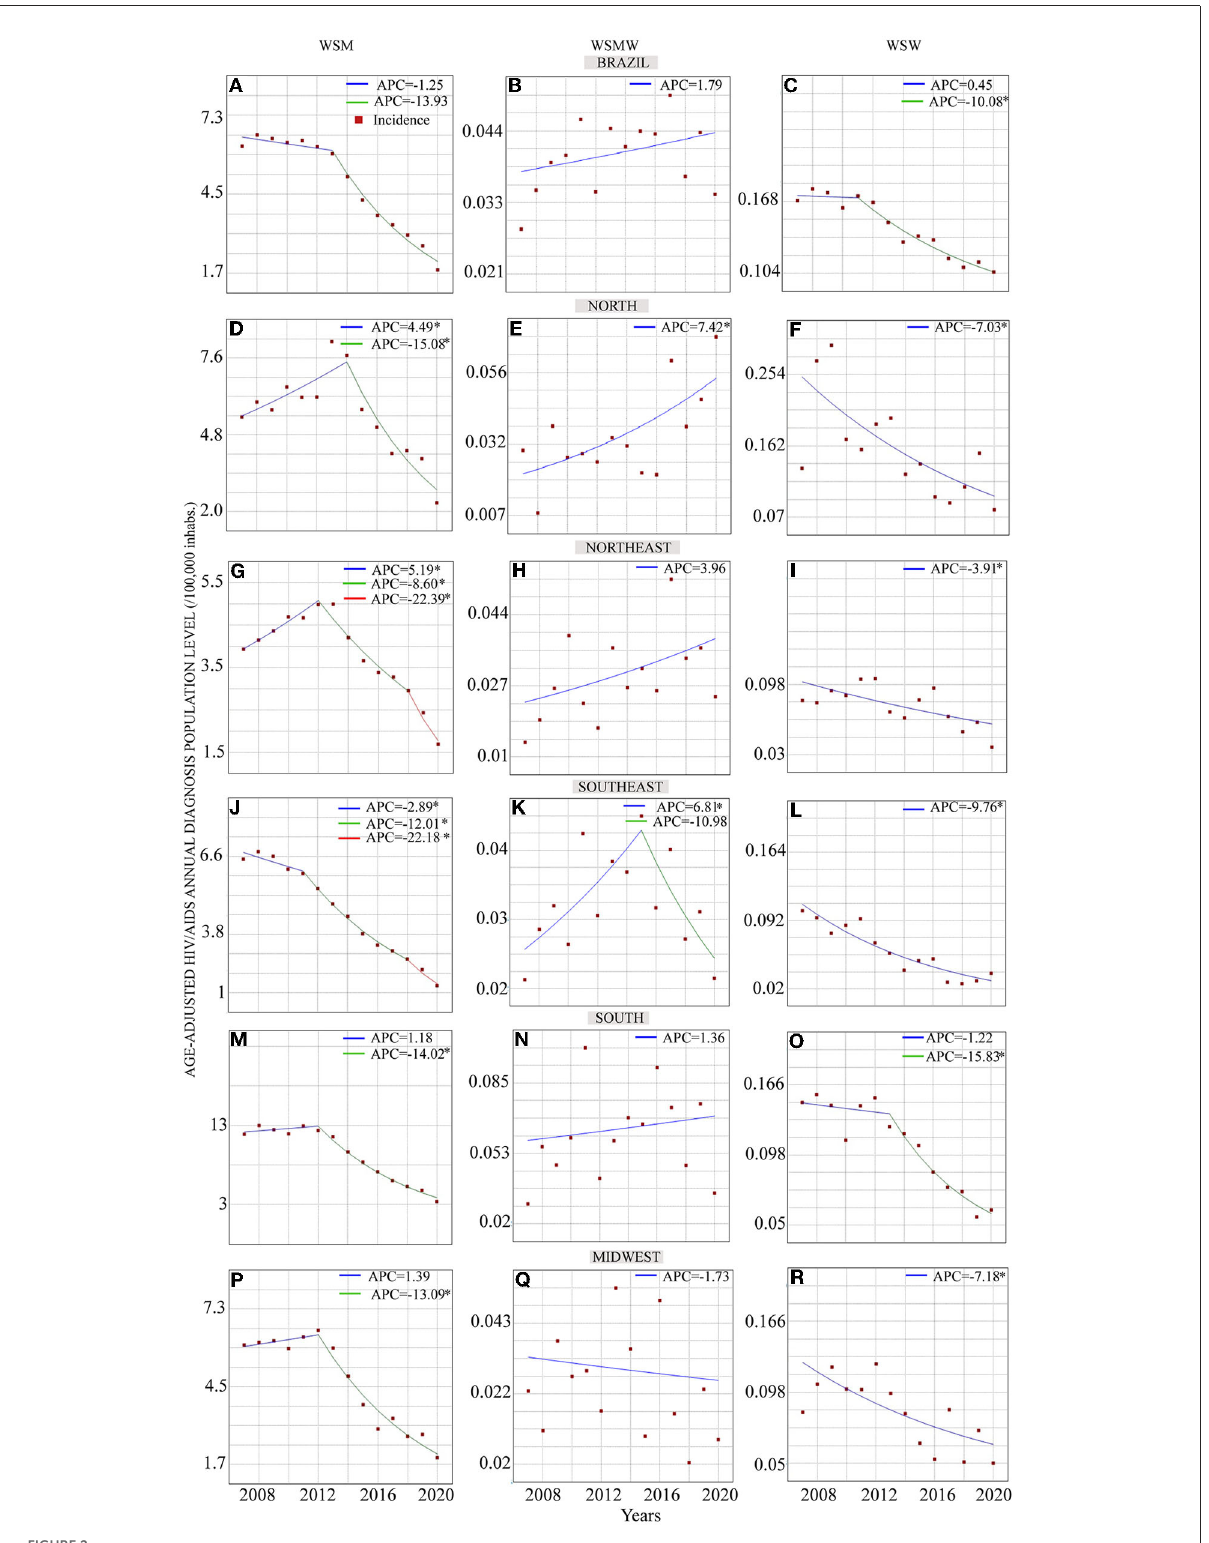
FIGURE2 Temporal trend analysis of HIV/AIDS regional aged-adjusted incidence rates in Brazilian WSM, WSMW and WSW. (A–C) The trends of the crude HIV/AIDS incidence rates in Brazil for WSM, WSMW, and WSW, respectively. The Brazilian regional aged-adjusted trends for WSM are shown in figures for (D,G,J,M,P) , and in figures (E,H,K,N,Q) for WSMW women, and for WSW in figures (F,I,L,O,R) . The blue, green and red traces represent a trend period. The red squares show the noticed HIV/AIDS incidences rates. * p -value <